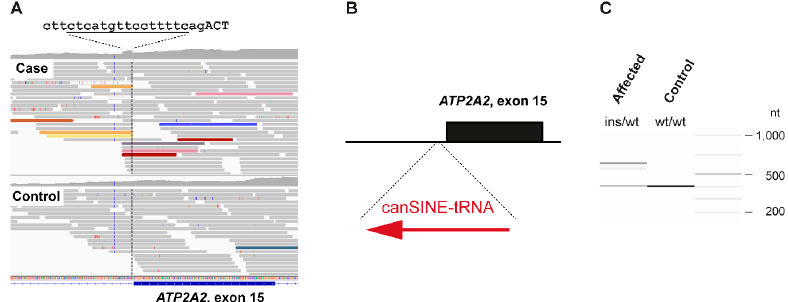
Figure 3. SINE insertion into intron 14 of the ATP2A2 gene. ( A ) IGV screenshot illustrating the structural variant. The case shows an increased coverage over 15 nucleotides spanning